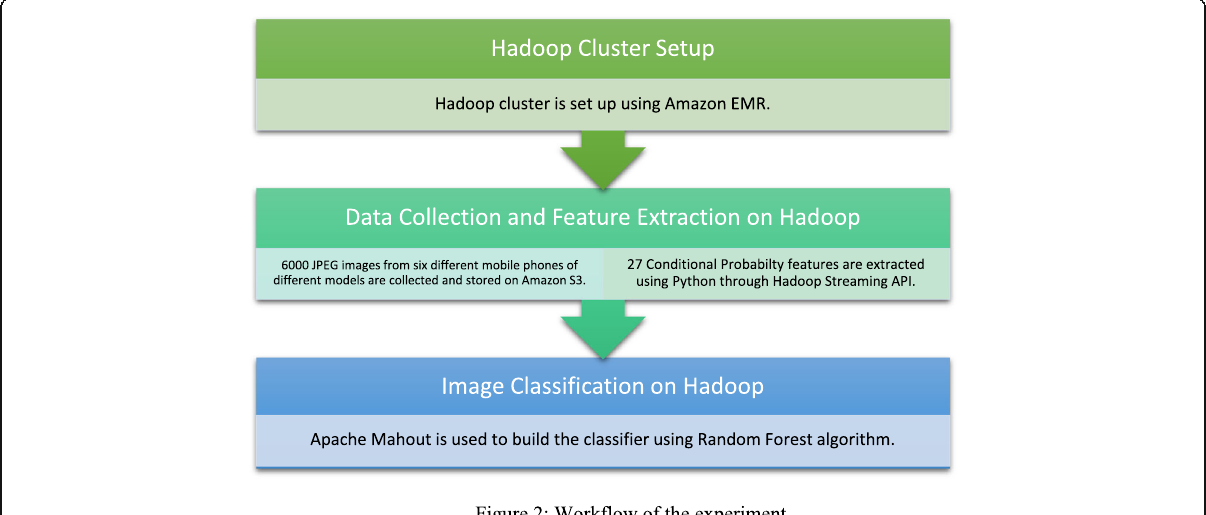
Fig. 2 Workflow of the experiment